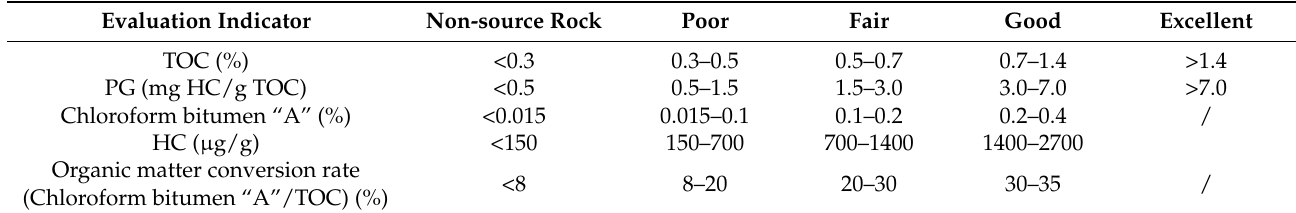
Table 2. Evaluation standard of continental alkaline lake source rock.